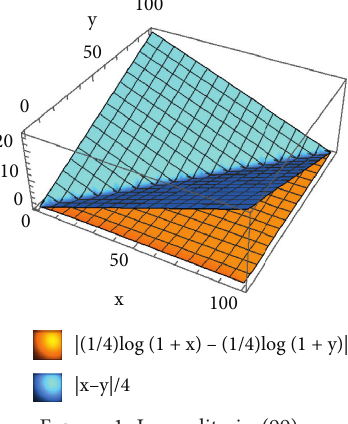
Figure 1: Inequality in (99).